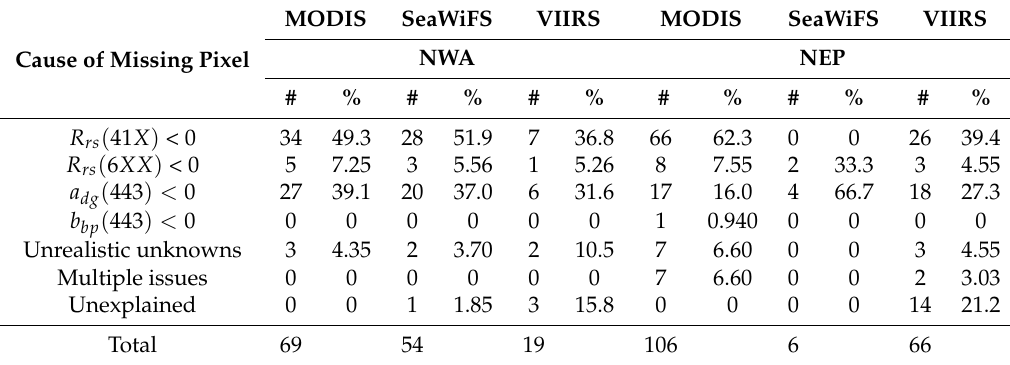
Table 6. Missing retrievals by GSM_GS algorithm for each region/sensor combination, subdivided by the cause of lost data, with the percentage of lost retrievals given for each cause. R rs ( 41 X ) is the remote sensing reflectance value at 412nm for MODIS and SeaWiFS, and 410nm for VIIRS. R rs ( 6 XX ) varies from 645 to 671 nm depending on sensor. Note that there were no instances of negative model chla , unlike a dg ( 443 ) and b bp ( 443 ) . “Unrealistic unknowns” occur when chla , a dg ( 443 ) , or b bp ( 443 ) are outside their acceptable ranges, given in Equation (9). Multiple issues were a combination of a dg ( 443 ) < 0 and chla above the acceptable range, with two instances where b bp ( 443 ) was also too high (>0.18).